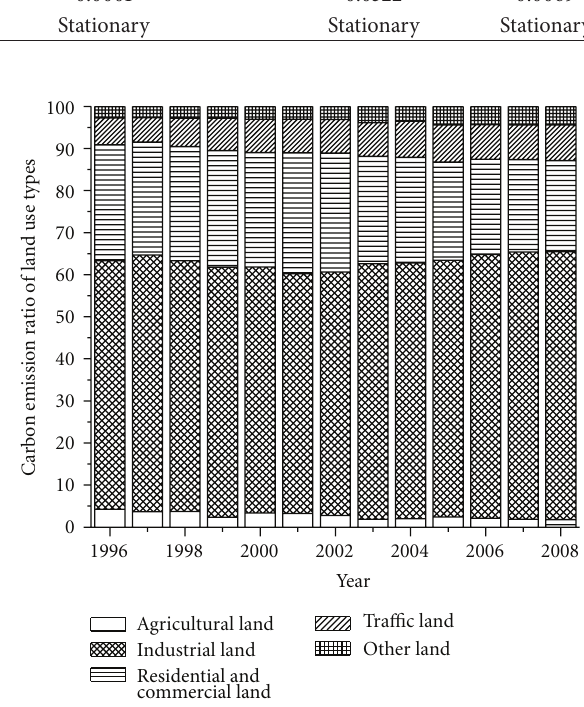
Figure 7: Composition of energy-related carbon emission.